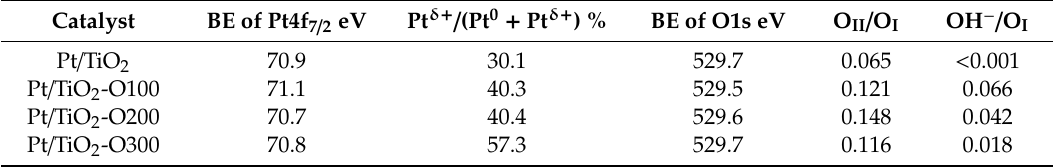
Figure 5. High-resolution XPS spectra for Pt4f and O1s of various catalysts ( a ) Pt / TiO 2 , ( b ) Pt / TiO 2 -O100, ( c ) Pt / TiO 2 -O200, and ( d ) Pt / TiO 2 -O300. Table 2. Analyses of X-ray Photoelectron Spectrometer (XPS) and CO di ff use reflectance infrared Fourier transformed spectroscopy (CO-DRIFTS) of various pre-oxidized Pt / TiO 2 catalysts and the pristine Pt / TiO 2